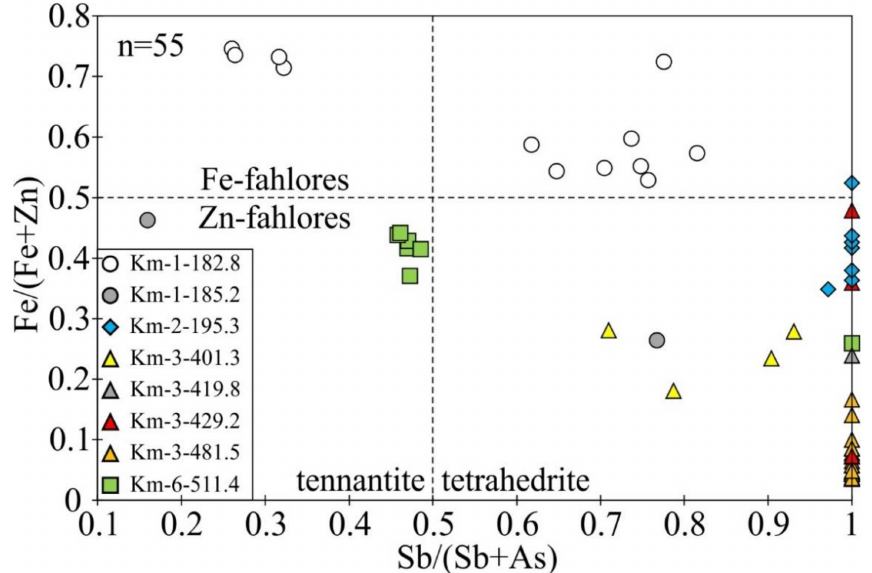
Figure 14. Variations in composition of fahlore (Fe, Zn, Sb and As apfu) from samples